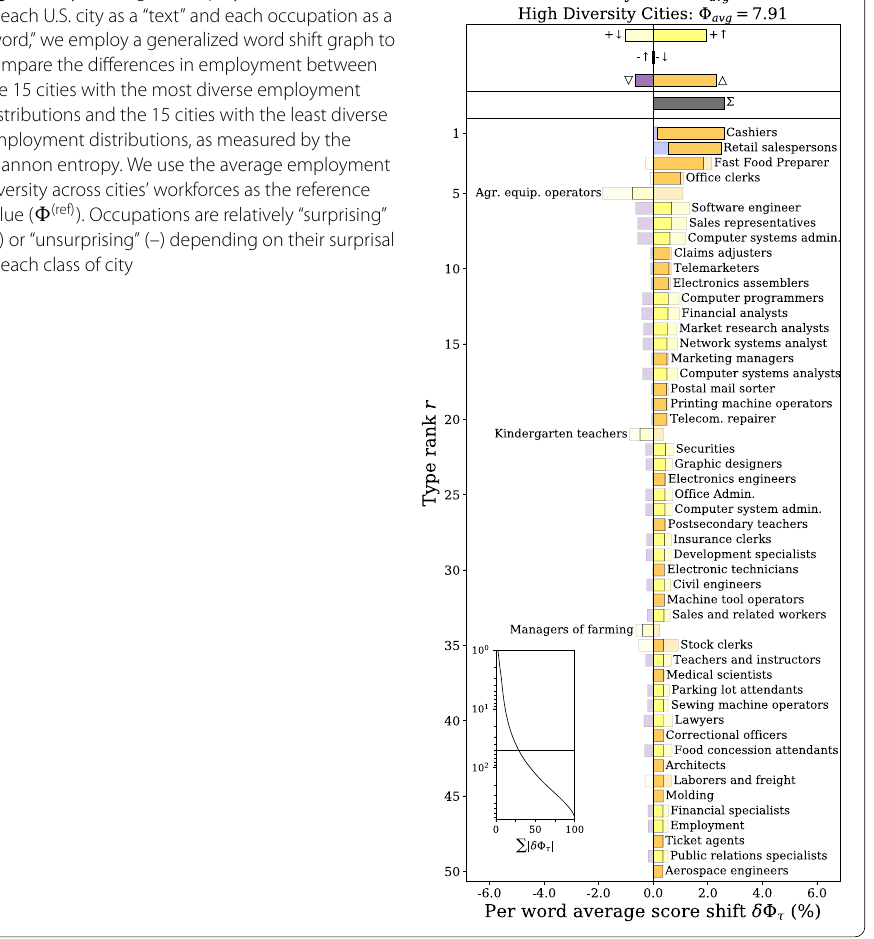
Figure 7 By treating the employment distribution in each U.S. city as a “text” and each occupation as a “word,” we employ a generalized word shift graph to compare the differences in employment between the 15 cities with the most diverse employment distributions and the 15 cities with the least diverse employment distributions, as measured by the Shannon entropy. We use the average employment diversity across cities’ workforces as the reference value ( (cid:6) (ref) ). Occupations are relatively